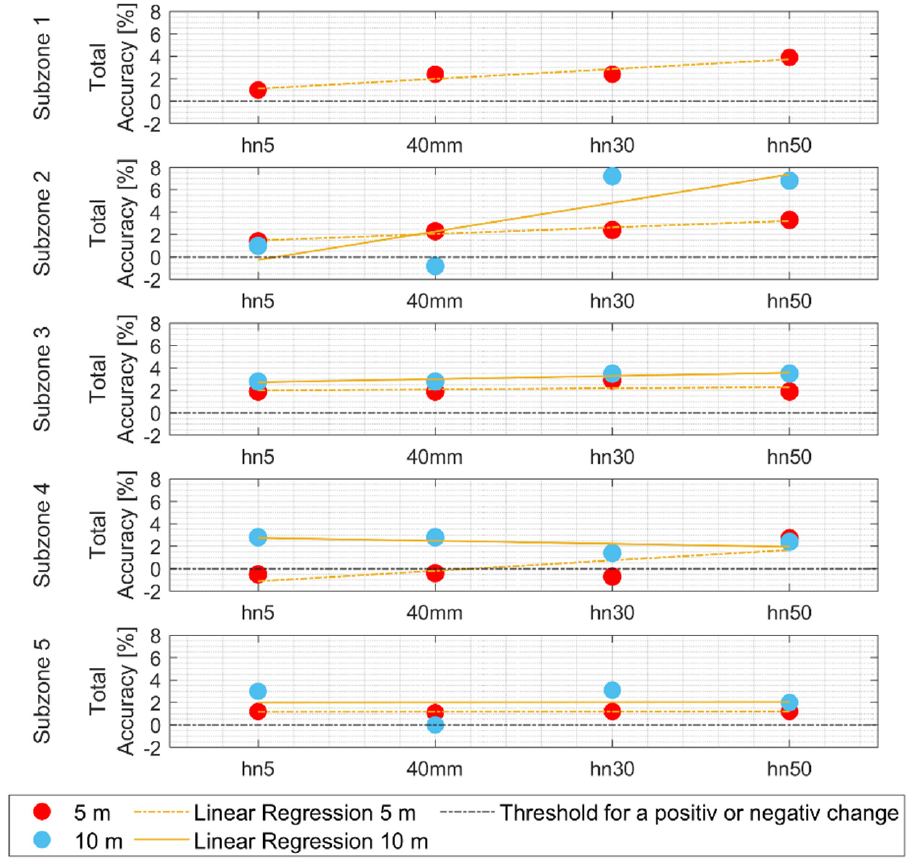
Figure 8. Total accuracy for different rainfall events (hN5 = 31.6 mm/h, hN30 = 47.5 mm/h, hN50 = 52 mm/h).